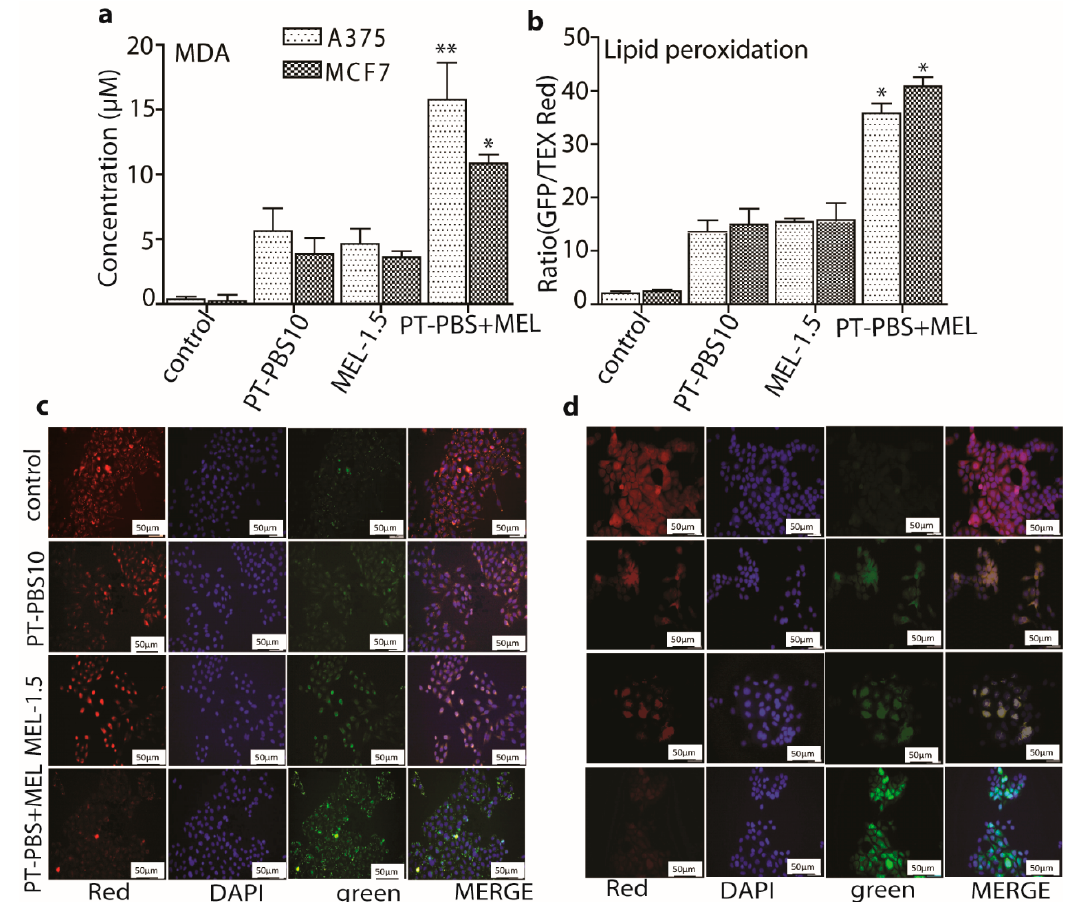
Figure 6. Change in membrane integrity upon PT-PBS 10, MEL-1.5 and combined treatment in both cancer cell lines, by ( a ) measurement of the concentration of the peroxidation product malondialdehyde (MDA), and ( b ) flow cytometry analysis with a fluorescent probe. All values are expressed as ± SD; * = p ≤ 0.05; ** = p ≤ 0.01. Fluorescence images of ( c ) A375 and ( d ) MCF7 cells, stained with lipid/lipid peroxide detection reagents. Red fluorescence represents non-oxidized membrane lipids, DAPI (blue) represents the nuclear counterstain and green represents the oxidized membrane lipids. Scale bars = 50 µm.